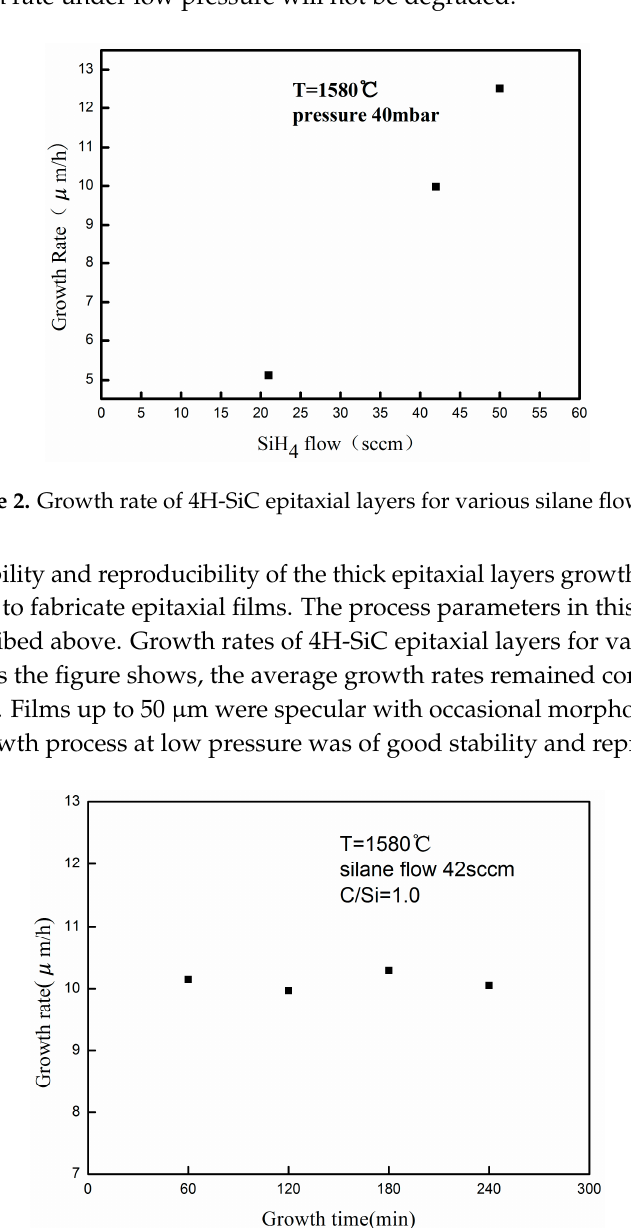
Figure 1. Dependence of 4H-SiC epitaxial growth rate on process pressure.